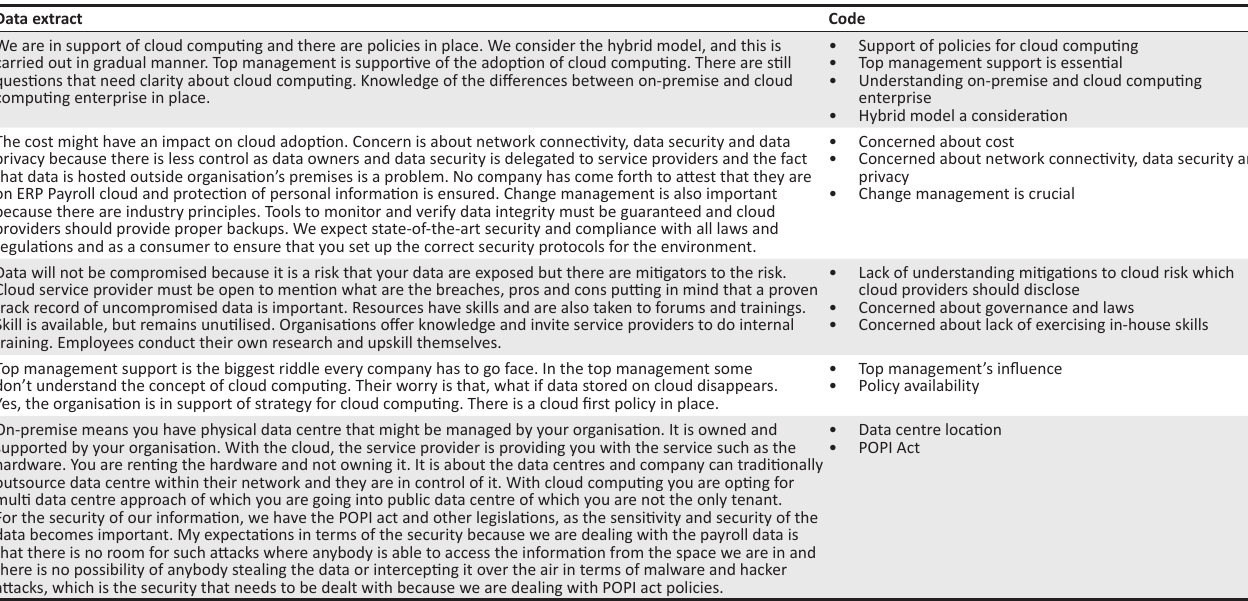
TABLE 2: Data extract that have been coded several times. Data extract